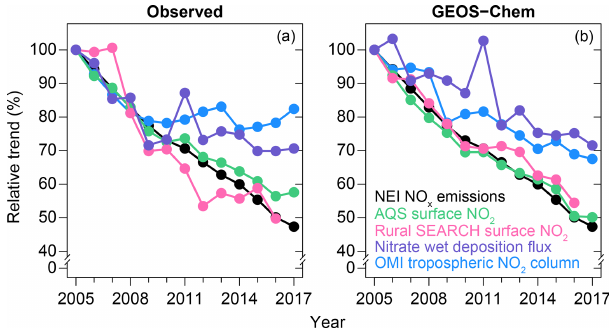
Figure 4. Relative trends since 2005 of NEI NO x emissions and relevant atmospheric quantities averaged over the contiguous US. Panel (a) shows observations and (b) shows the GEOS-Chem sim- ulation. NEI NO x emissions are the same in both panels. The SEARCH network was discontinued in